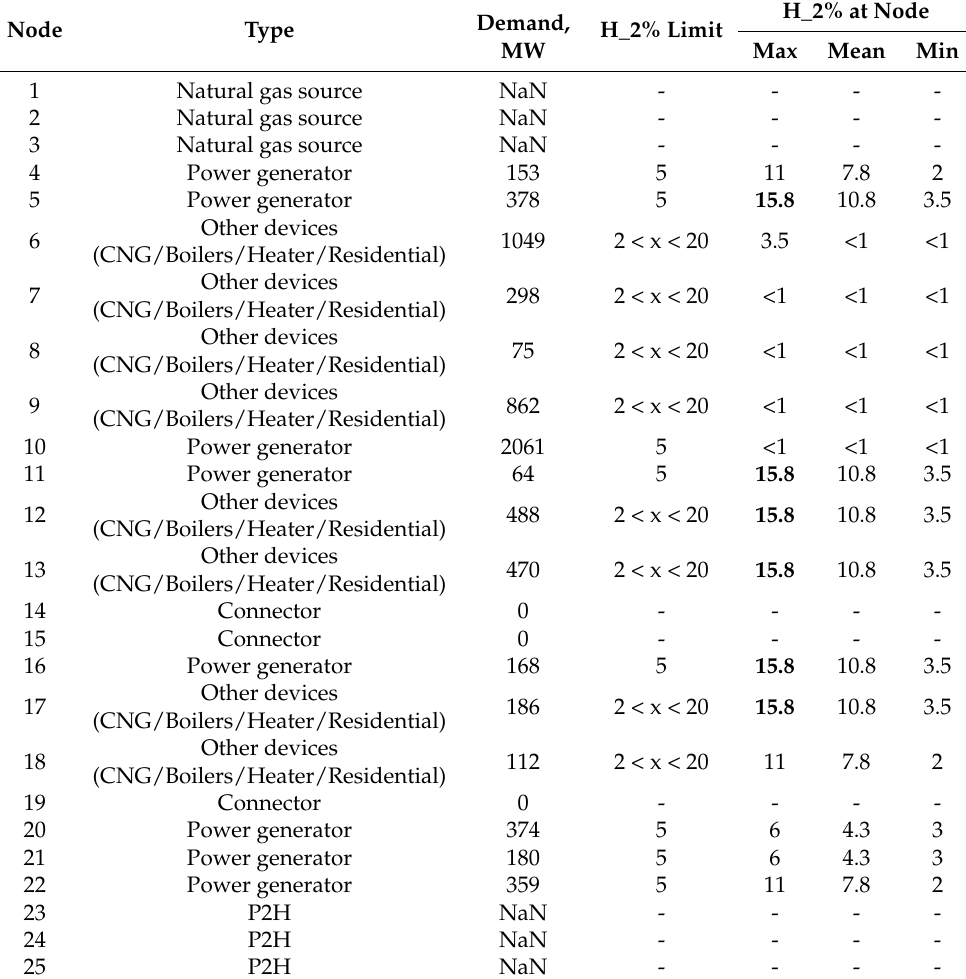
Table A2. Demand, end user hydrogen limits and hydrogen percentages during simulated